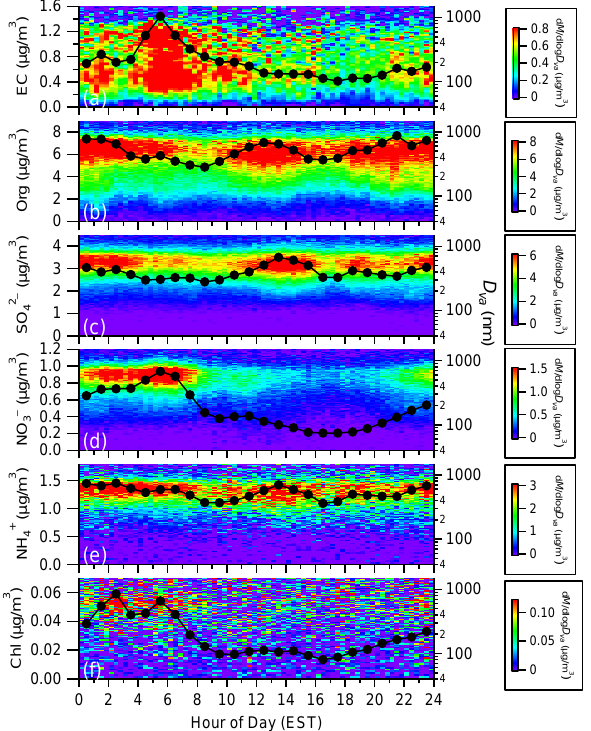
Fig. 3. Diurnal profiles of the mass concentrations (solid black cir- cles) and the size distributions of EC, organics, sulfate, nitrate, am- monium, and chloride.